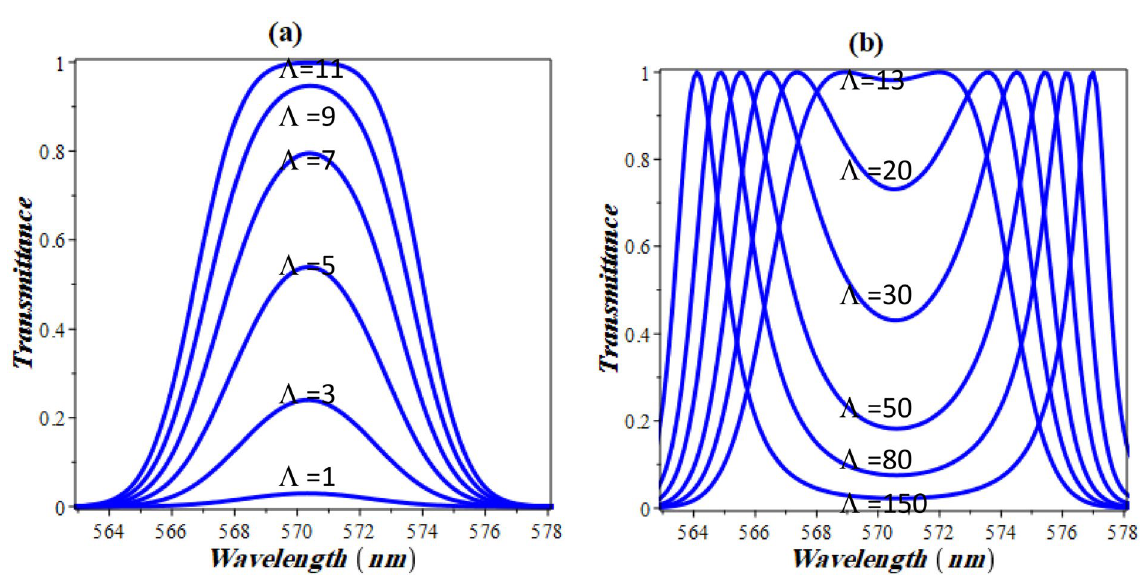
Figure 4. The effect of the nonlinearity coefficient on the transmittance spectrum of the designed structure for: ( a ) one defect mode like resonance and ( b ) two defect modes like